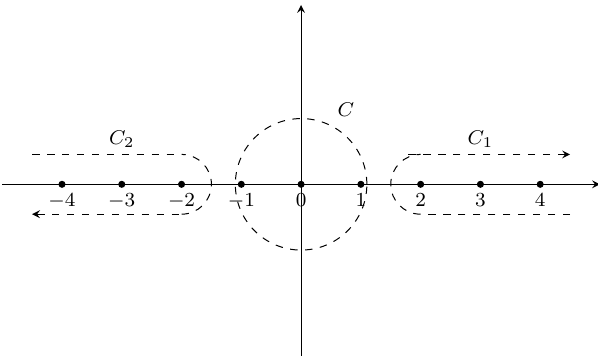
Figure 10 . Contour deformation: the integrand of I ( (cid:18) ) is analytic in the whole plane except the integer points x 2 Z . Therefore we can deform the contour C 1 [ C 2 that encloses j x j > 2 integer points to C which only encloses three points 0 ; (cid:6)